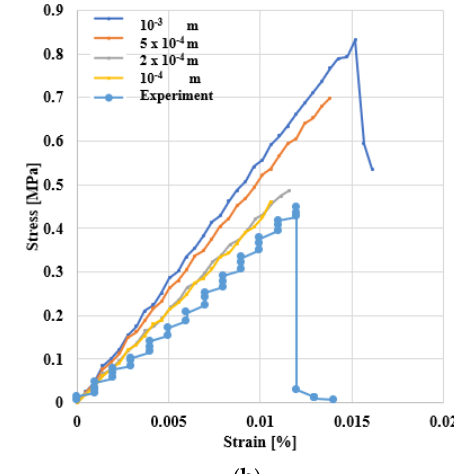
Figure 8. Broken bitumen sample in the simulation.